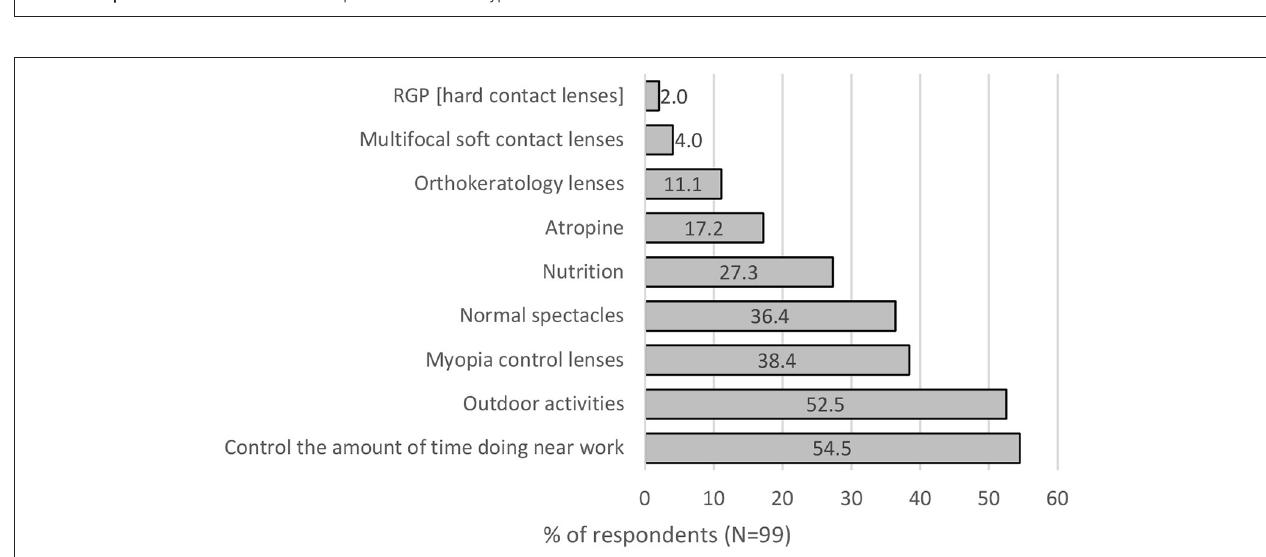
FIGURE 3 | The factors that will influence parents to use the type of vision correction.